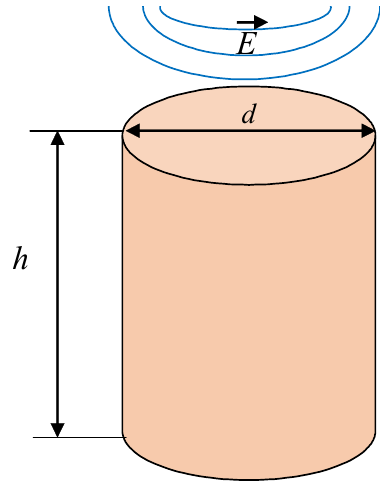
Figure 3. Scheme of the computational domain.